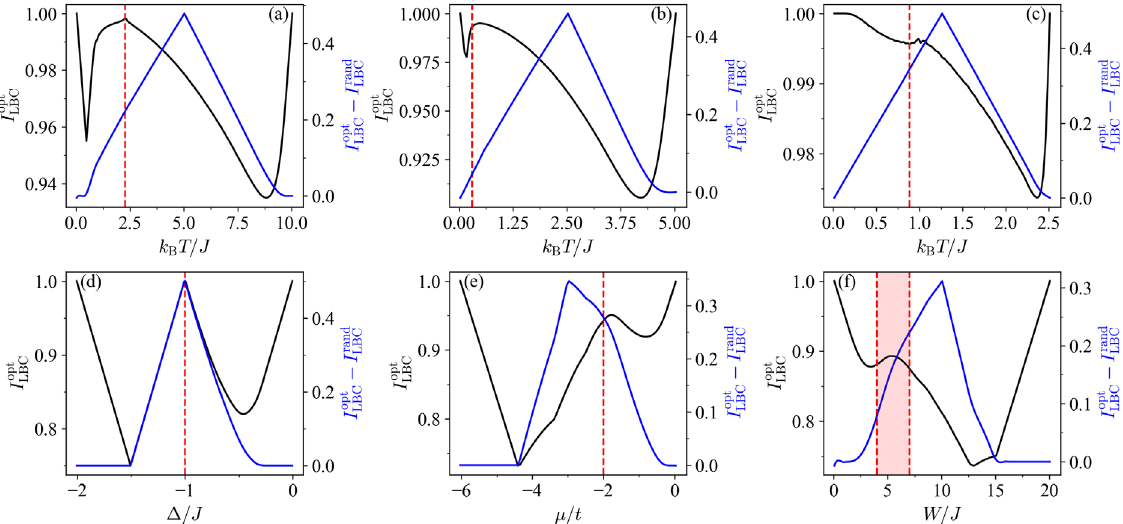
(2019).FIG. 20. Optimal indicator of LBC before (black line) and after (blue line) background subtraction for the (a) Ising model ( L ¼ 60 ), (b) IGT ( L ¼ 28 ), (c) XY model ( L ¼ 60 ), (d) XXZ chain ( L ¼ 14 ), (e) Kitaev chain ( L ¼ 20 ), and (f) Bose-Hubbard model ( L ¼ 8 ); see Sec. IV in the main text. The corresponding critical values of the tuning parameters are highlighted in